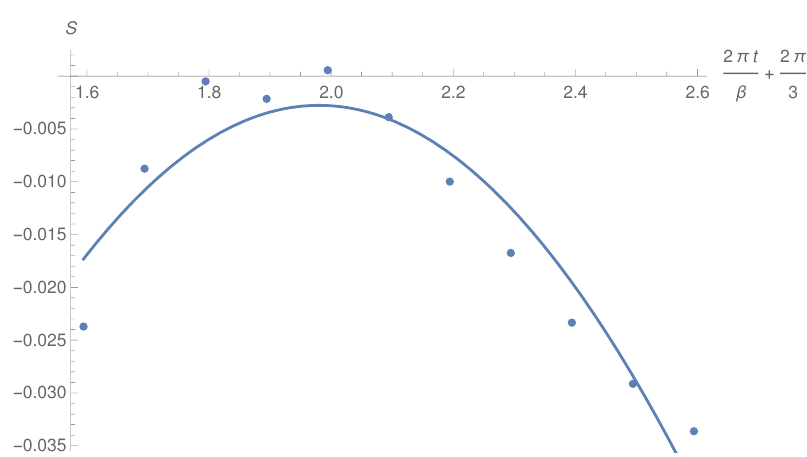
Figure 7: Six point OTOC with 3-fold Schwinger-Keldysh contour. Step-size = 0.05, λ = L